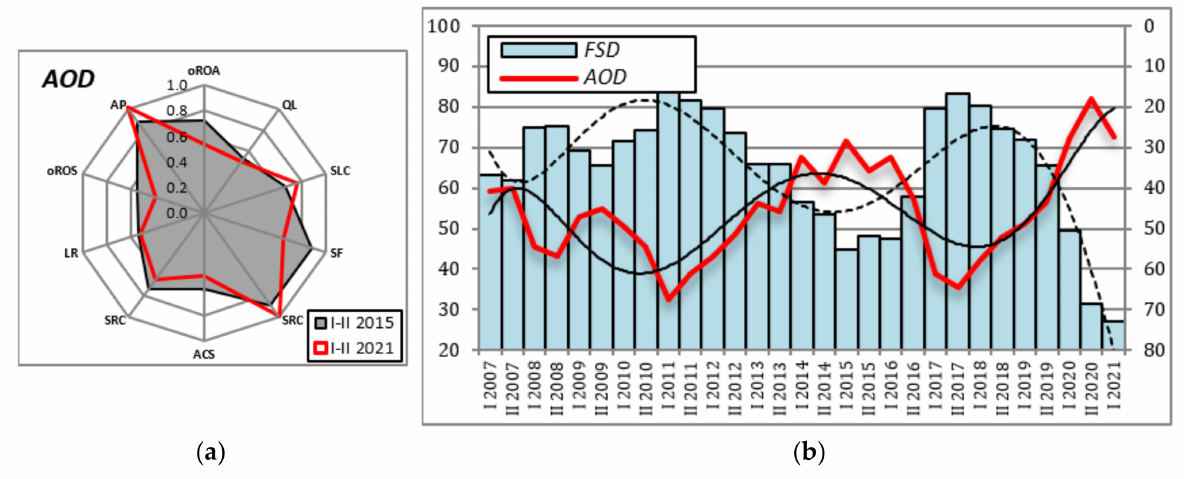
Figure 8. Relationships of multivariate measures: ( a ) AOD and its components in coal mining companies in 2007–2019 (half-year data); ( b ) AOD and financial security degree ( FSD ) in coal mining companies in 2007–2019 (half-year data). Note: AOD —standardised values. FSD —dimensionless values, left axis. Source: as in Figure